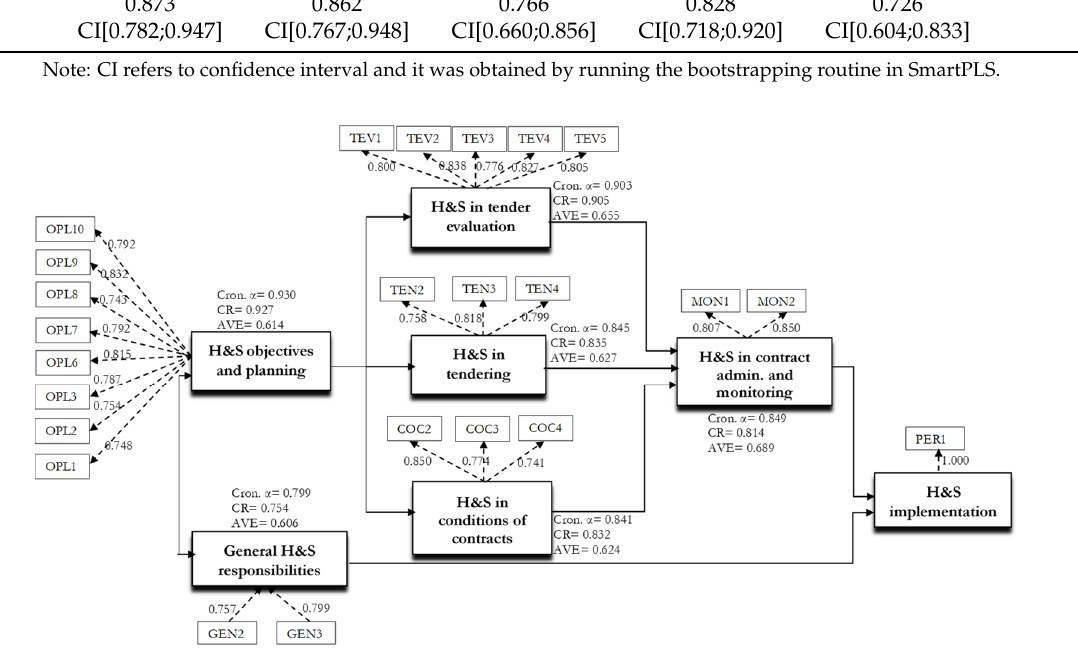
Table 6. Model fit indices summary.